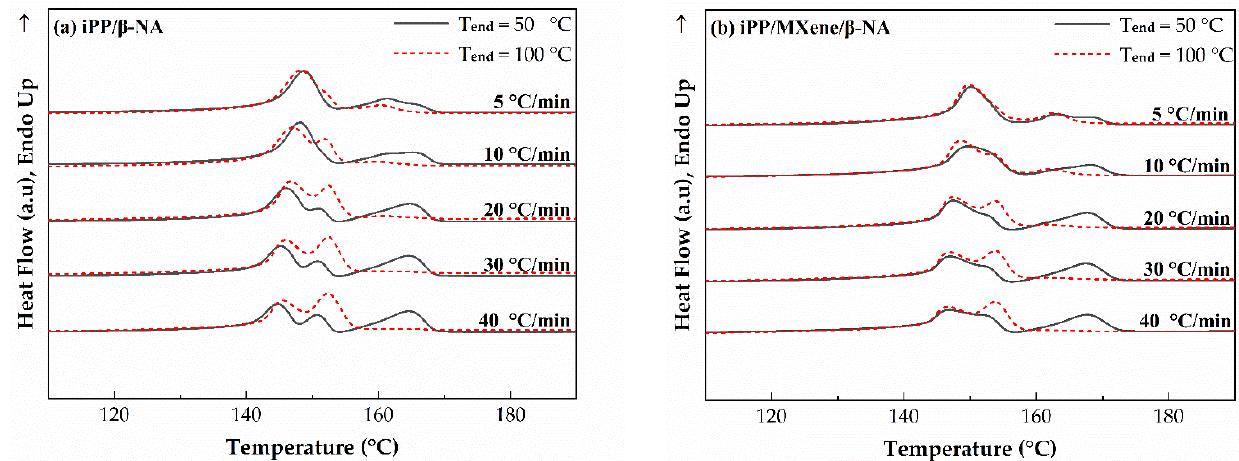
Figure 10. DSC melting curves of ( a ) iPP/ β -NA and ( b ) iPP/MXene/ β -NA at two end temperatures.